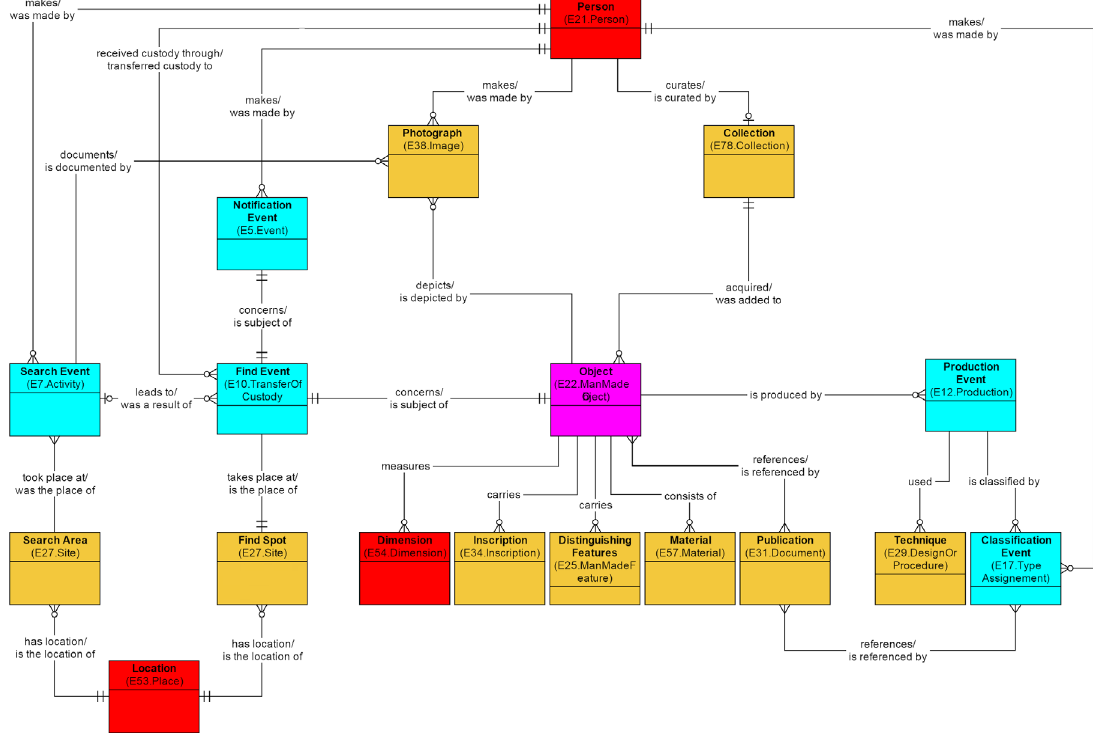
Figure 3. The MEDEA data model, identifying the 18 core entities and their relationships. These entities represents the domain knowledge captured by the MEDEA